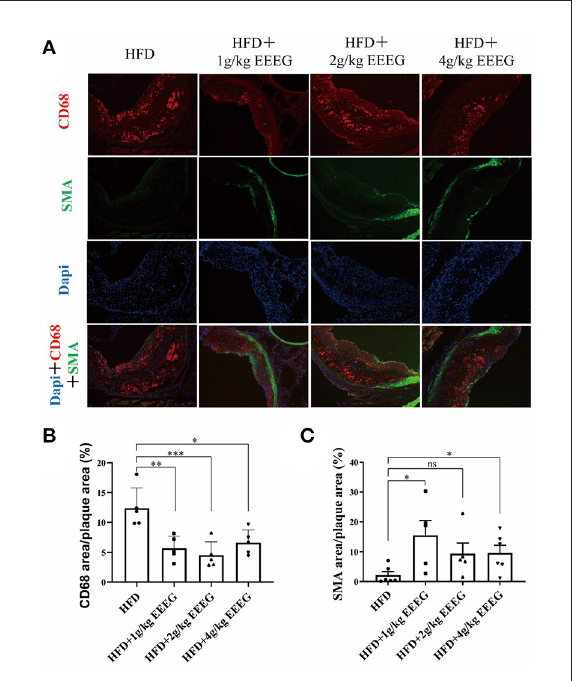
FIGURE6 EEEG treatment significantly inhibits macrophage infiltration in the aortic root of mice. (A) Representative images of CD68 (macrophages, red) and α -SMA ( α -smooth muscle actin; green, smooth muscle cells) immunostaining of aortic root sections. (B,C) Quantitative analysis of macrophages and smooth muscle cell content in the aortic root sections. HFD ( n = 5), HFD + 1 g/kg EEEG ( n = 5), HFD + 2 g/kg EEEG ( n = 5), HFD + 4 g/kg EEEG ( n = 5), Data are expressed as mean ± s.e.m., Statistical analysis was based on Graphpad Prism 9.0.2 software and a value of P < 0.05 was considered statistically significant. One-way ANOVA with Student Neuman-Keuls post-hoc test was performed